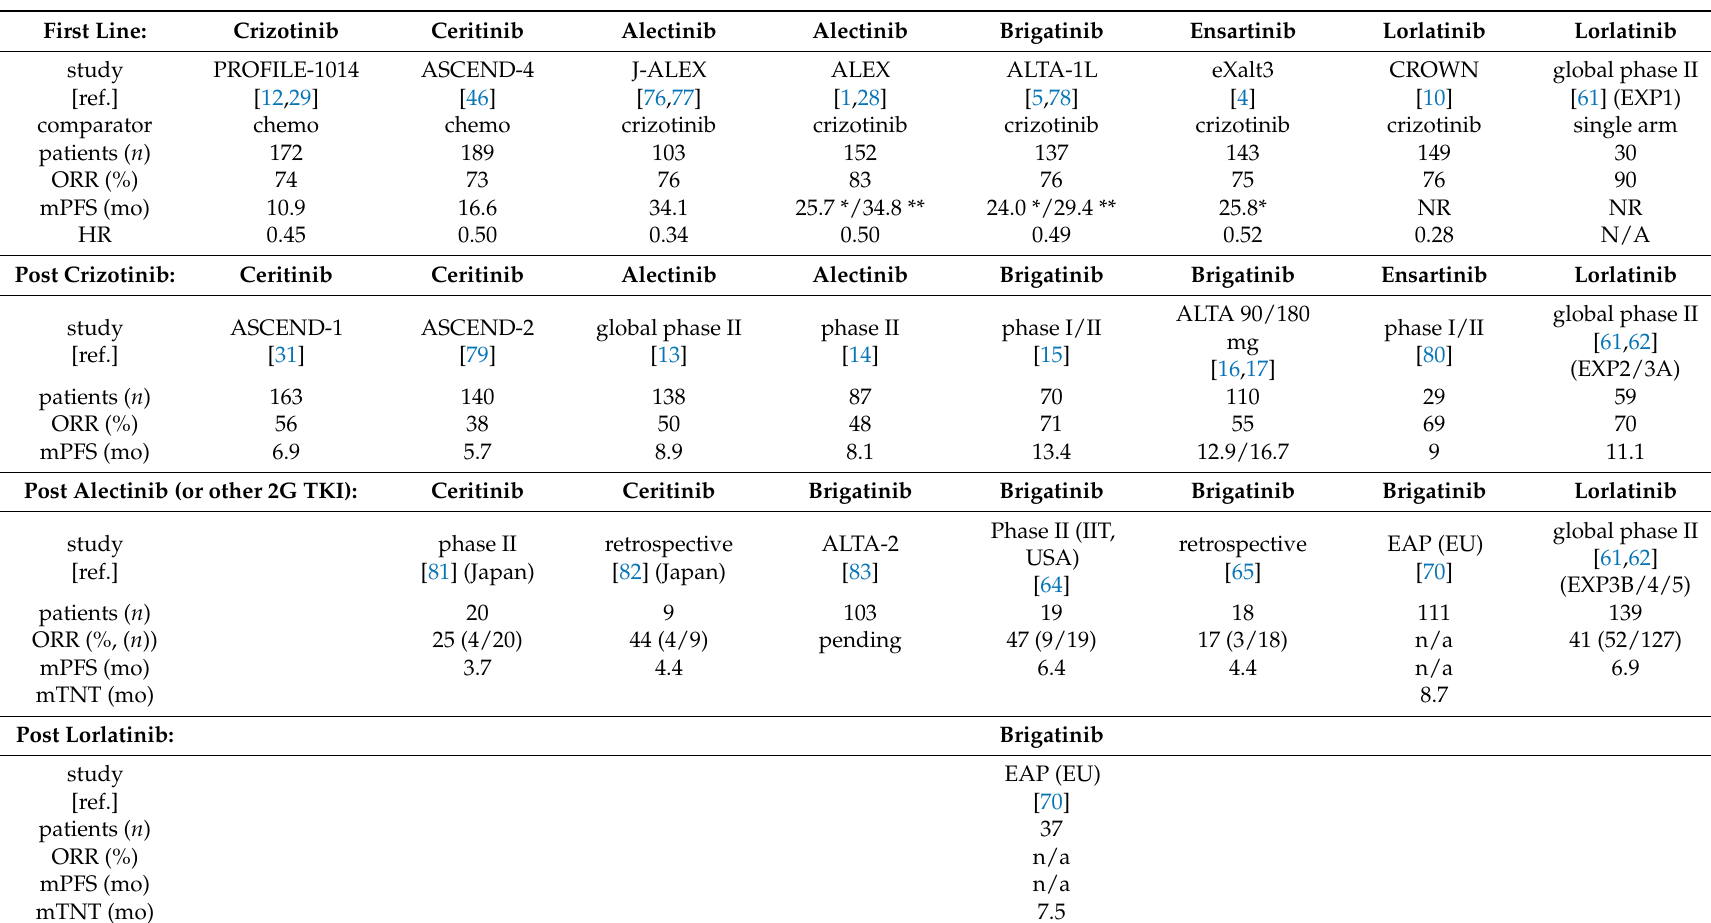
Table 1. Systemic efficacy of ALK inhibitors upfront and as next-line treatment for ALK +